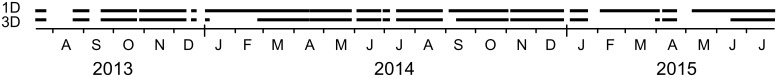
Periods of continuous data collection.1D denotes data which did not always include angular information, which were used for obtaining fish counts; 3D denotes data which did include angular information, which were used for determining fish target strength and times of slack tide (description in text).